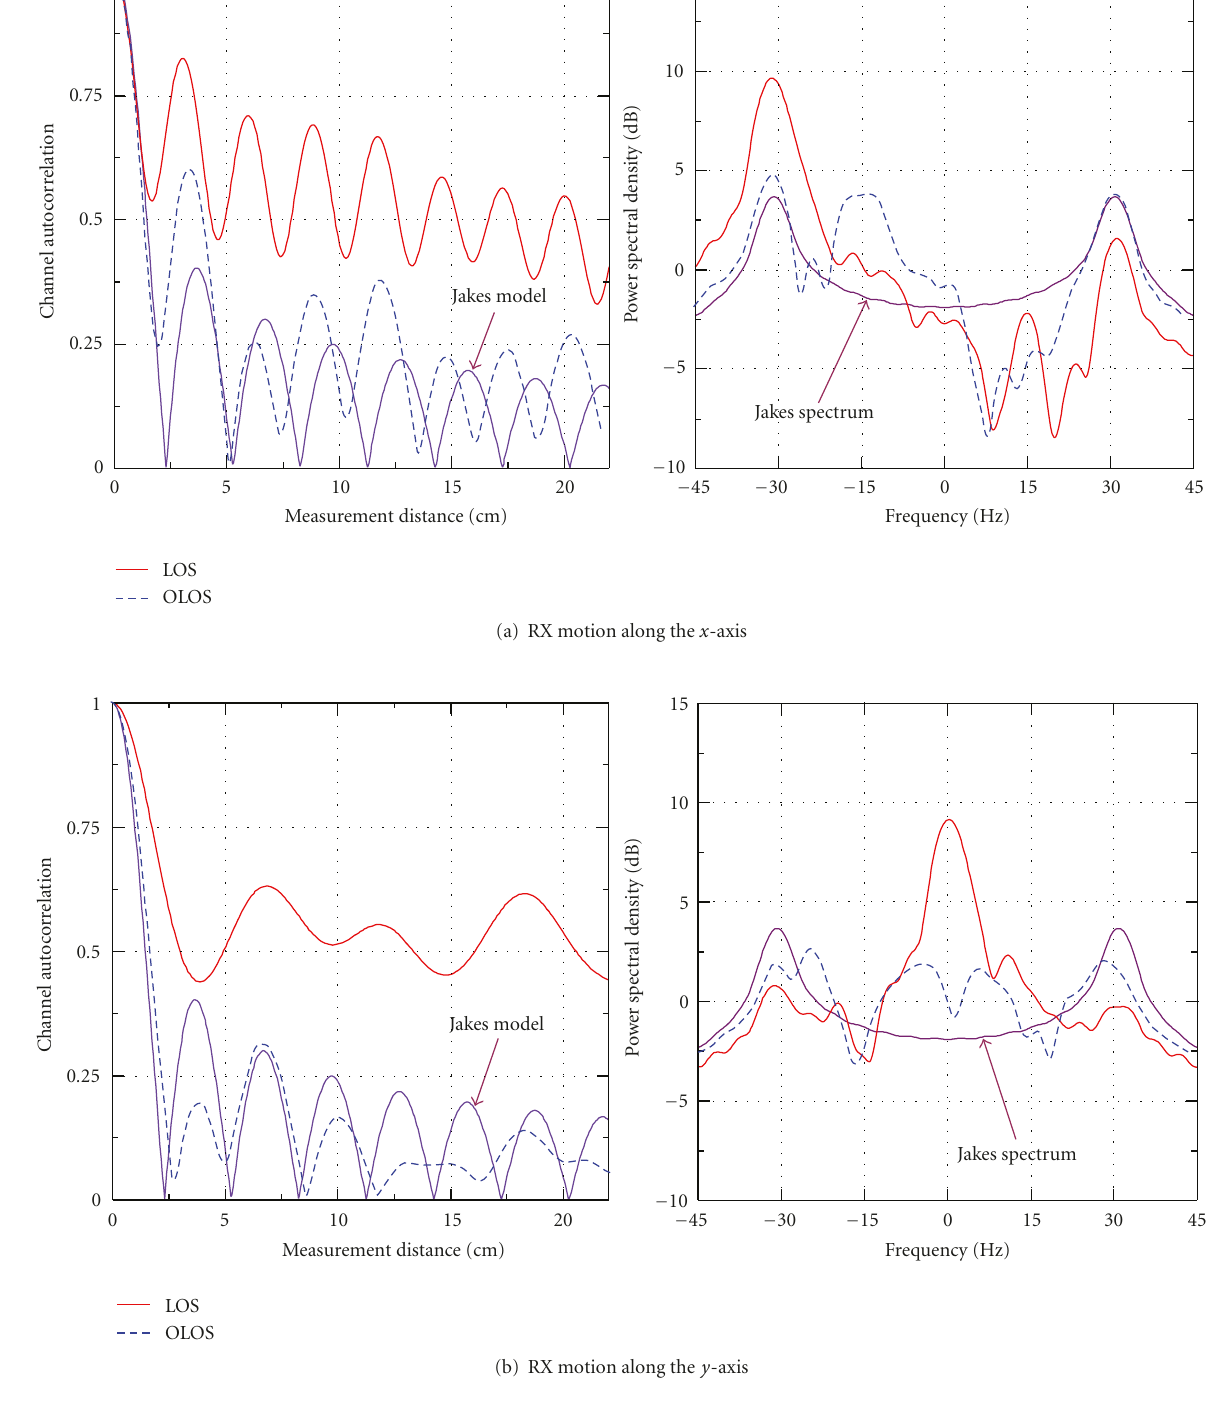
Figure 12: Channel autocorrelation and Doppler spectrum for f D = 31 Hz of SISO channel.